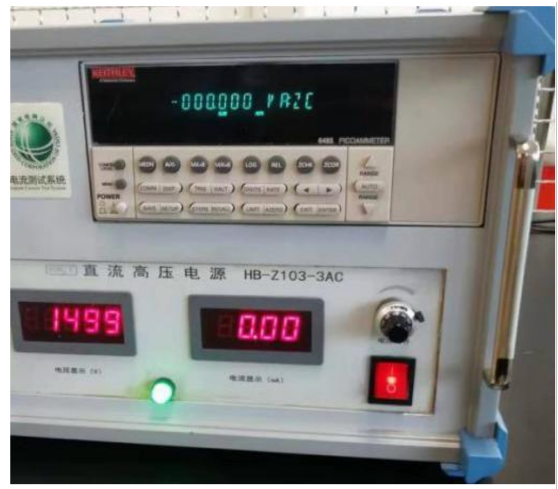
Figure 6. PDC measuring